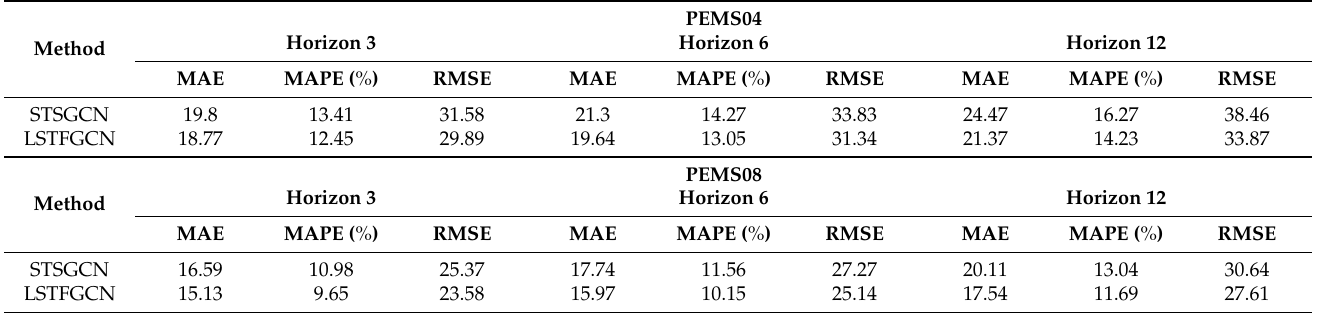
Table 3. Comparison of prediction results of LSTFGCN and STSGCN on Horizon 3, Horizon 6 and Horizon